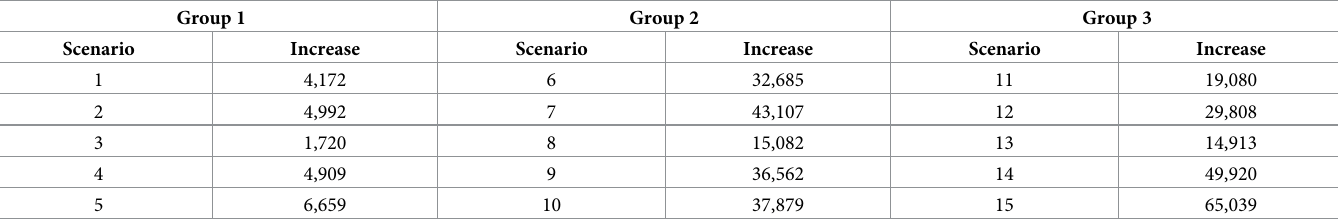
Table 12. Increase of average revenue.